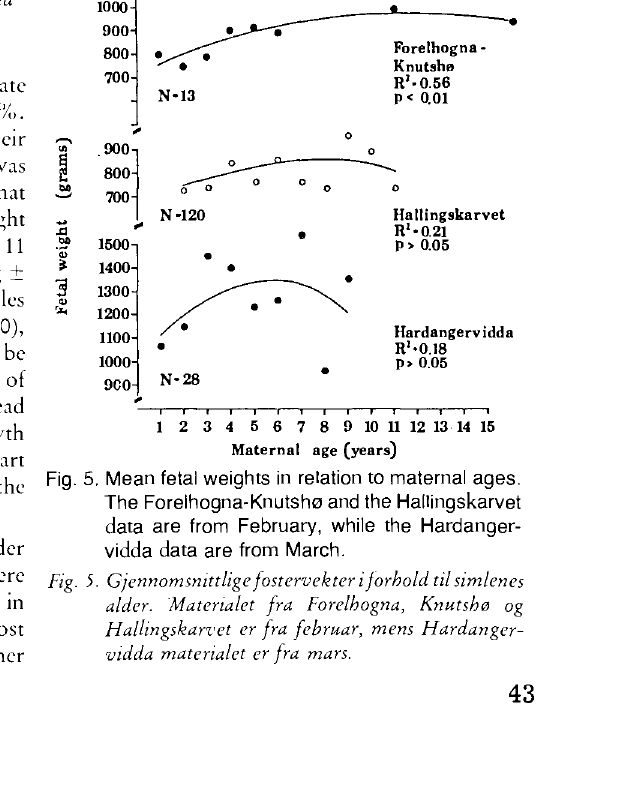
Fig. 4. The realtionship between mean maternal dressed weights and age in the four study herds. The Forelhogna and Knutshø data have been pooled since they did not differ in size. Data from the autumn hunting season have also been added for these herds (Skogland 1983, 1984b). Fig. 4. Forholdet mellom simlenes gjennomsnittlige slak tevekter og alder i de fire villreinstammene. Materialet fra Knutshø og Forelhogna er slatt sammen da det ikke var forskjellig. Det er også